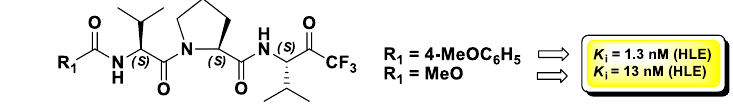
Figure 13. Chemical structures, progressive SAR analysis, and K i values towards human leukocyte elastase (HLE) of the most relevant t-PFMKs developed by Brown F.J. and co-workers.